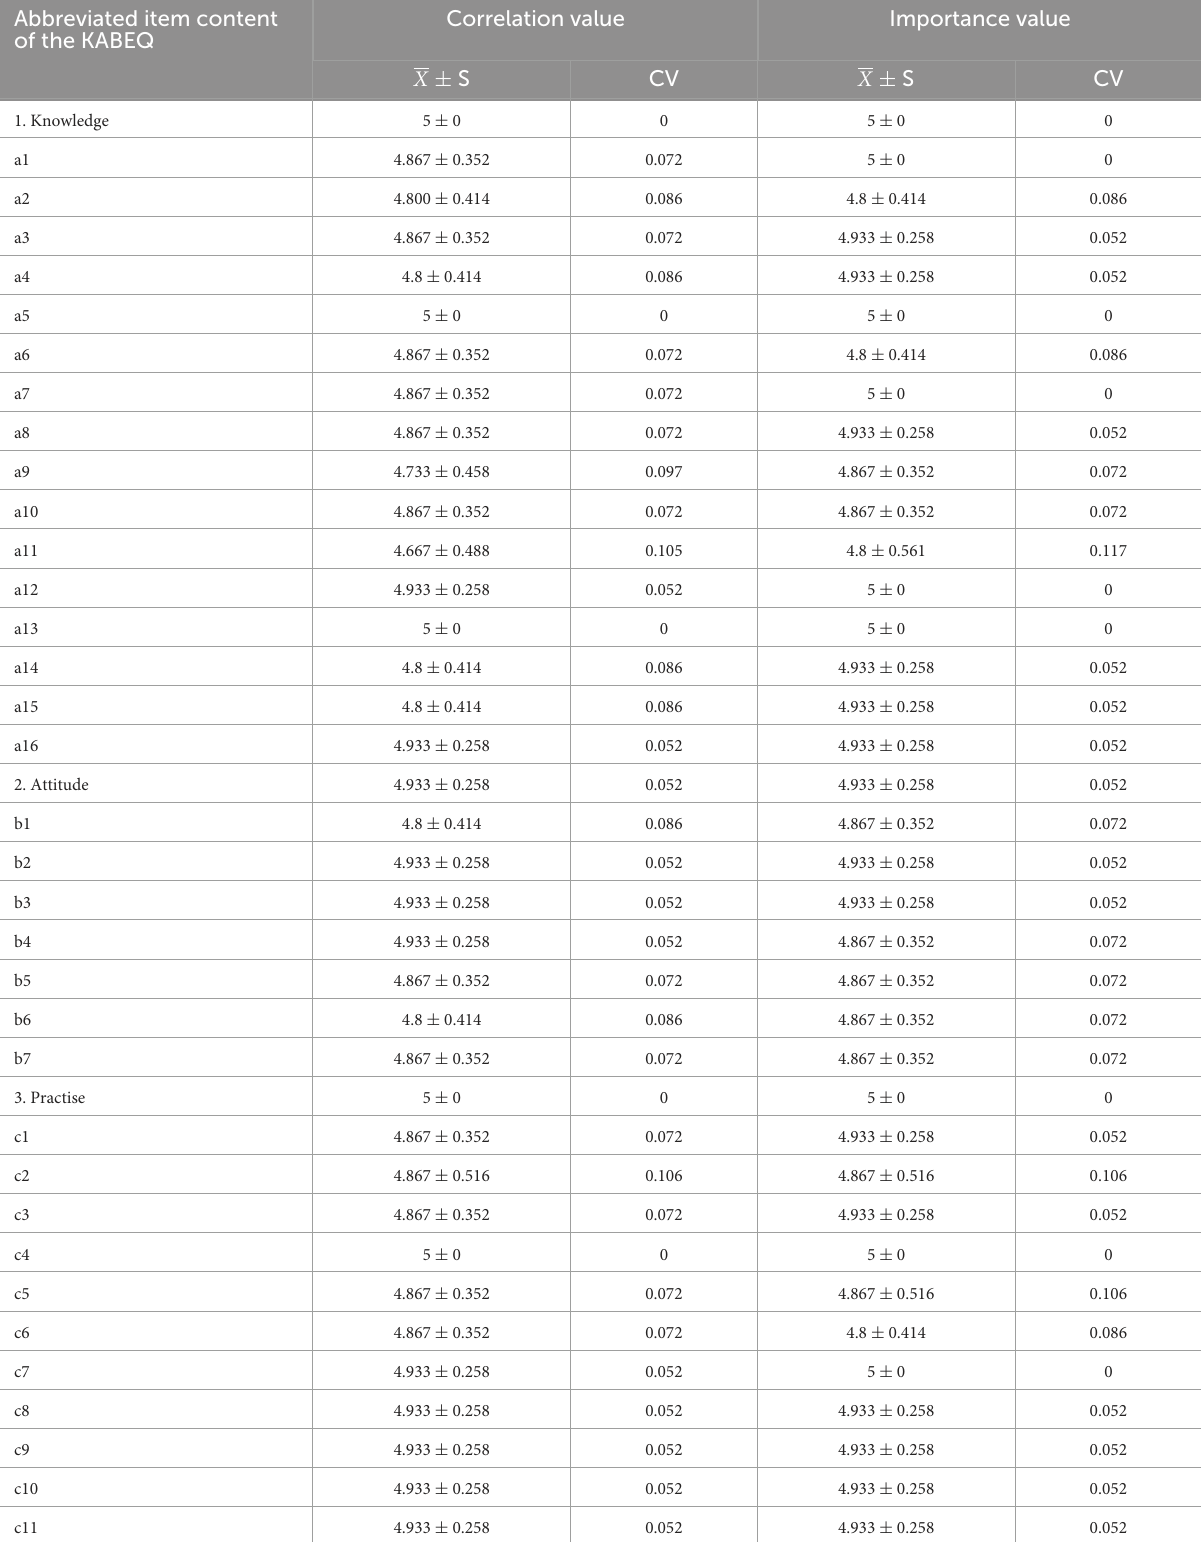
TABLE 4 Results of Delphi round 2 ( N =